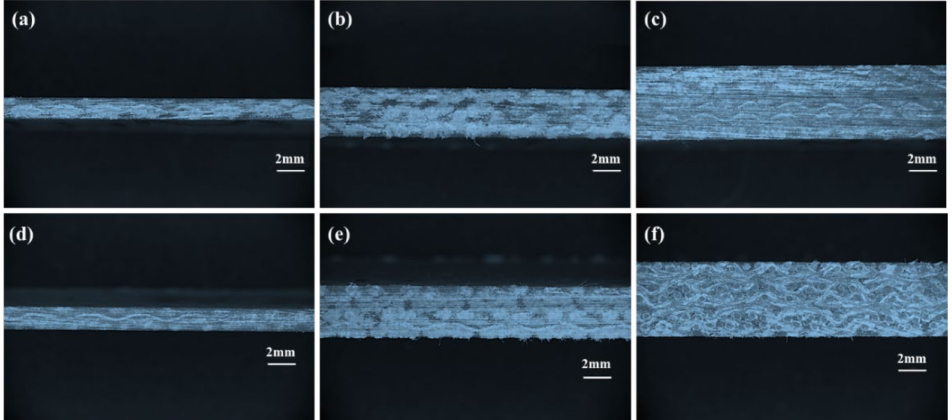
Figure 1. Cross-sections of composite specimens: ( a ) 1 layer, ( b ) 3 layers, ( c ) 5 layers of hemp composites; ( d ) 1 layer, ( e ) 3 layers, ( f ) 5 layers of ramie